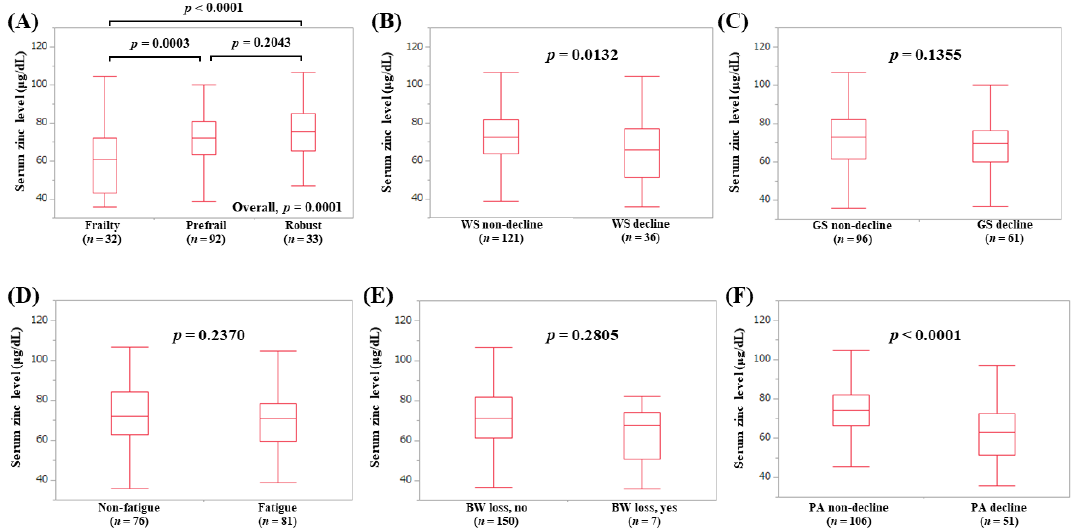
Figure 6. Serum Zn level according to the frailty status ( A ) and serum Zn level according to each frailty phenotype in patients aged 65 years or more: ( B ) walking speed, ( C ) grip strength, ( D ) fatigue, ( E ) body weight loss, ( F ) physical activity.